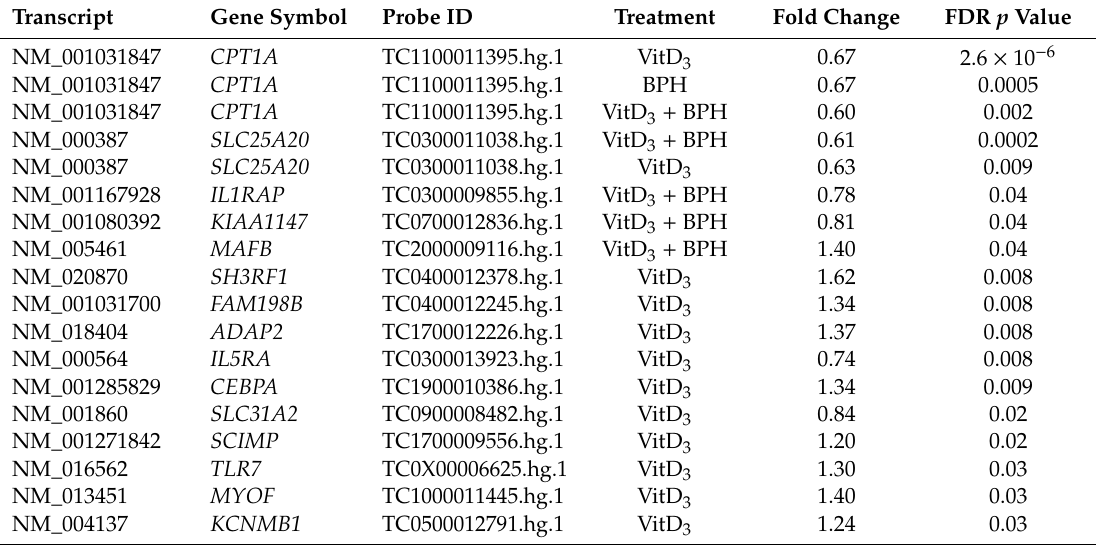
Figure 1. Heat maps of probe expression levels. ( a ) Heat map and hierarchical clustering of mean transcript expression levels before (Time = 0) and 3 h after (Time = 180) each treatment (24 351 expression probes). ( b ) Heat map depicting fold changes in expression levels after vs. before treatment for di ff erentially expressed probes (false discovery rate (FDR)-adjusted p value ≤ 0.05). Table 4. Di ff erentially expressed transcripts for the BPH, VitD 3 and VitD 3 + BPH treatments.